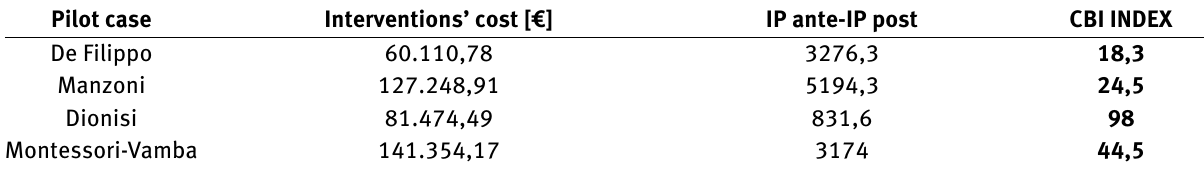
Table 5: Evaluation of the CBI in the pilot areas located in Florence. Pilot